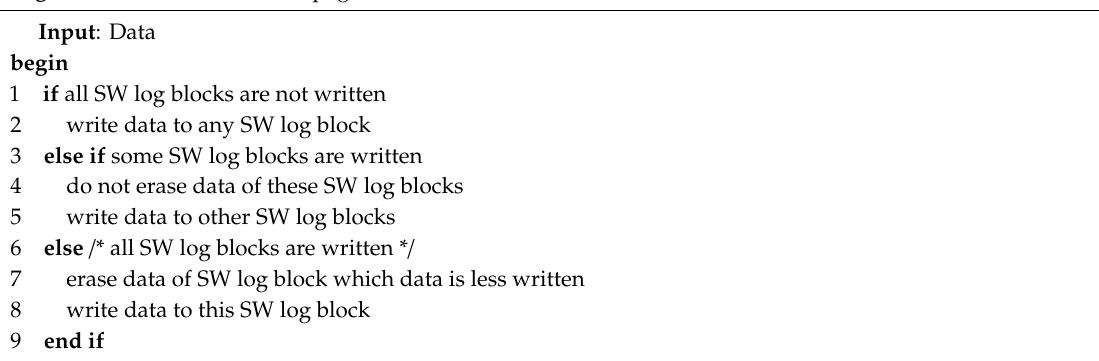
Algorithm 1: When data with page o ff set zero is written